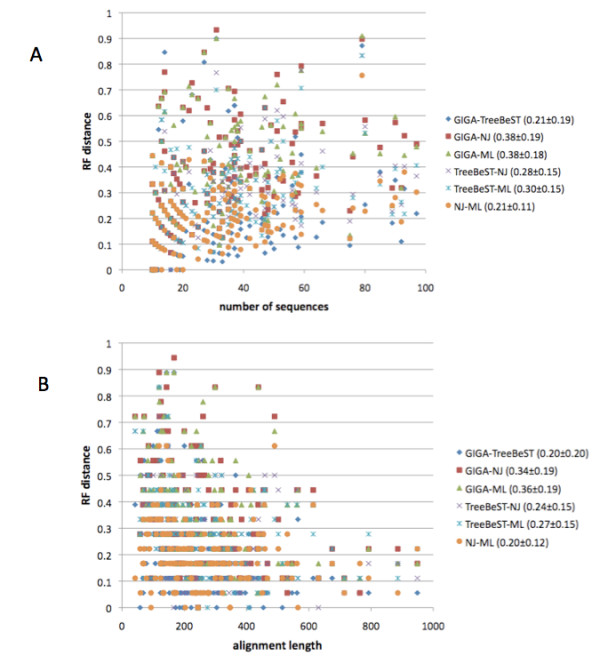
Comparison of multiple different tree reconstruction methods. The RF distance of each pair of trees is plotted versus (A) the number of sequences in the family and (B) the length of the alignment to show the dependence on these parameters. GIGA and TreeBeST (blue diamonds) generally yield more similar trees than any other pair of methods, except for NJ-ML, which is of comparable similarity. The RF distance mean and standard deviation for each pair of methods is in the figure legend in parentheses. The same subsets of TreeFam families was used as for Figure 6.